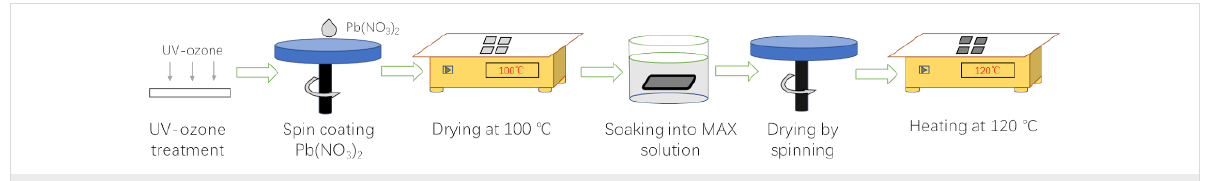
Figure 1: Fow chart of the preparation the PSCs.